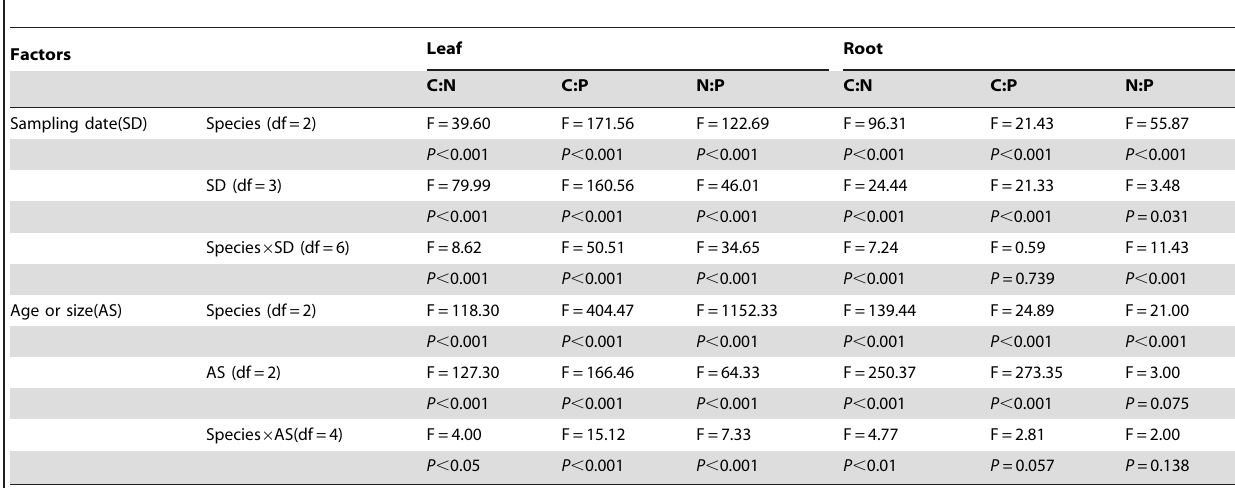
Table 1. Multivariate ANOVA results for the effects of species, plant sampling date, leaf age and root size on C:N, C:P, N:P ratios in the sand culture